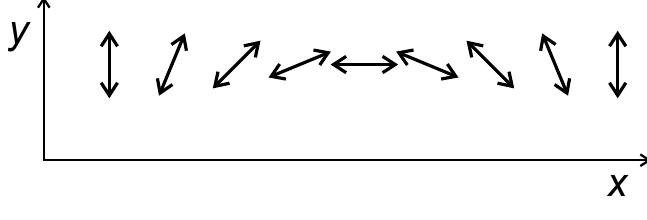
Figure 9. Scheme of continuous polarization